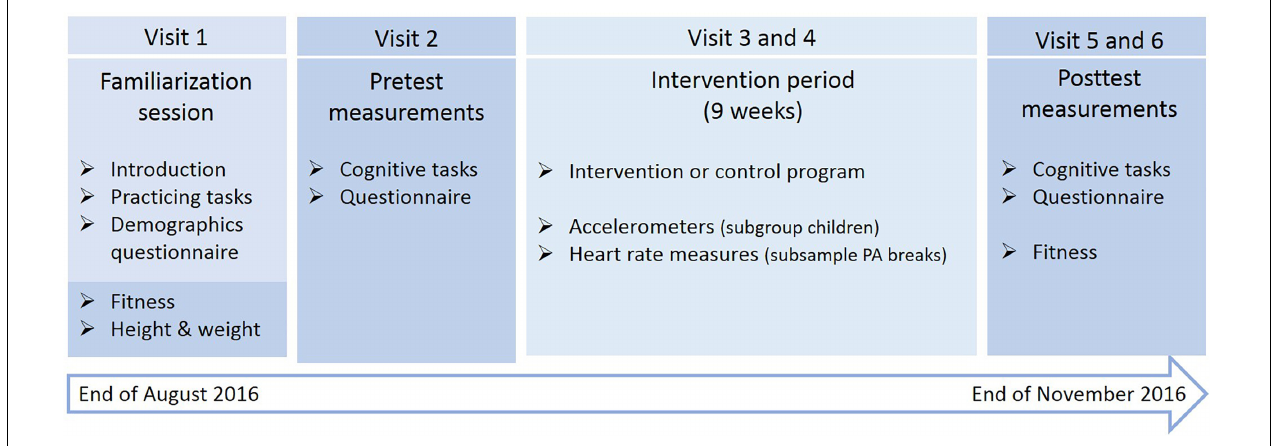
FIGURE 1 | Overview and timeline of the